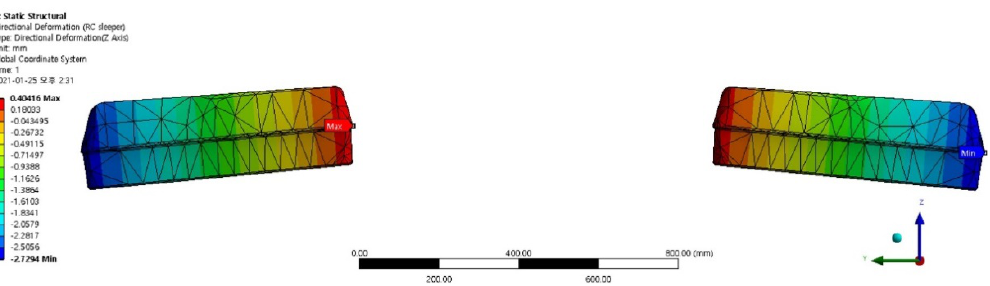
Figure 5. FE analysis results for the vertical displacement of the RC sleeper.